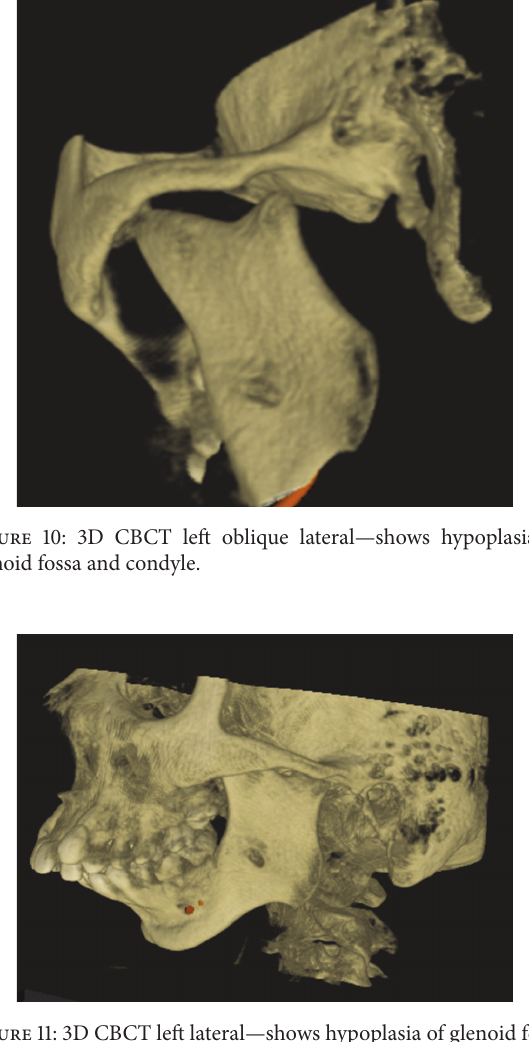
Figure 11: 3D CBCT left lateral—shows hypoplasia of glenoid fossa and